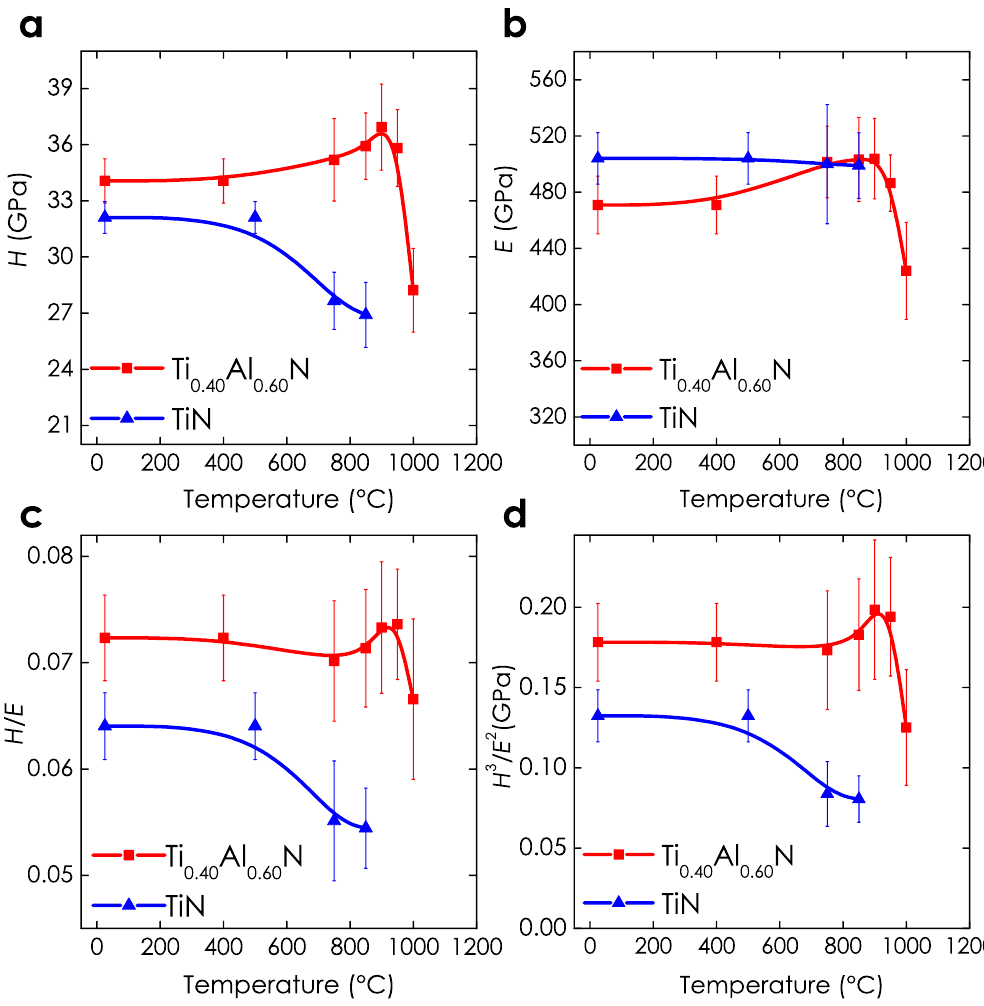
Figure 3. Hardness ( H ), indentation modulus ( E ), ( H / E ), and ( H 3 / E 2 ) ratios of Ti 0.40 Al 0.60 N as a function of annealing temperature (annealing time = 10 min). Age-hardening effects and implications on the toughness criteria are clearly